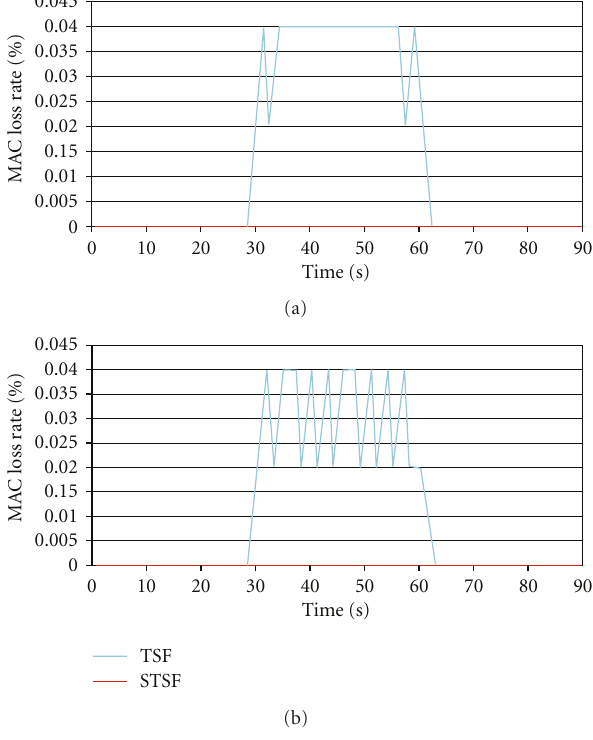
Figure 13: MAC loss rate comparison: (a) for the disabled handshake and (b) for the enabled